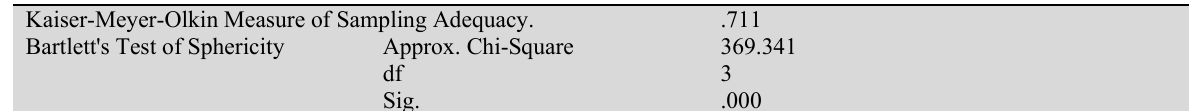
The results of KMO and Bartlett’s test Kaiser-Meyer-Olkin Measure of Sampling Adequacy.